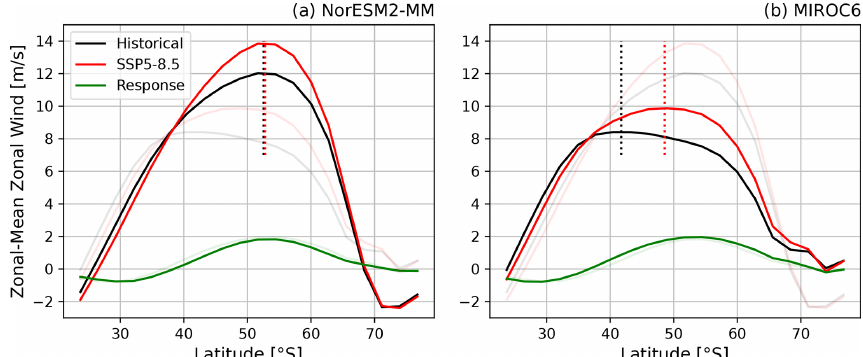
Figure 1. JJA zonal-mean zonal wind climatology of historical and SSP5–8.5 scenarios and their difference for two selected CMIP6 models: (a) NorESM2-MM and (b) MIROC6. Dotted vertical lines denote the jet latitude. For better comparison both panel (a) and (b) also show the curves of the respective other model as shaded